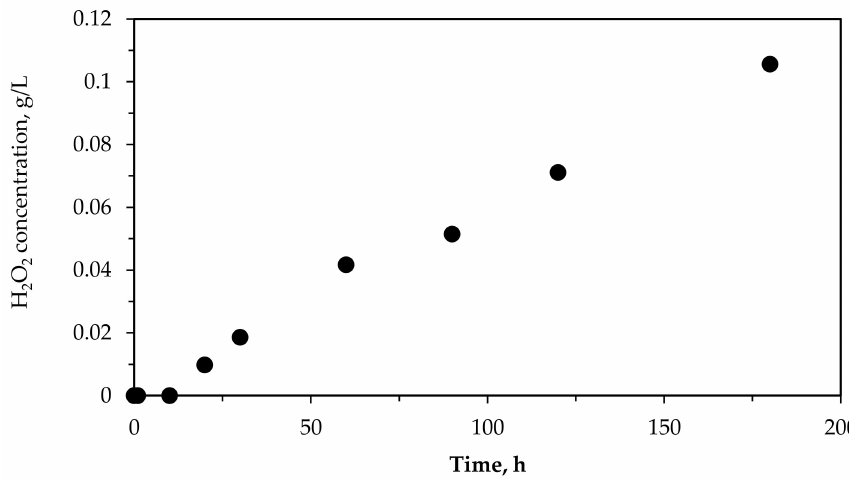
Figure 4. H 2 O 2 production using tap water in presence of catalyst (HFeO 2 ) and UV-light generated by the lamp used in this work.